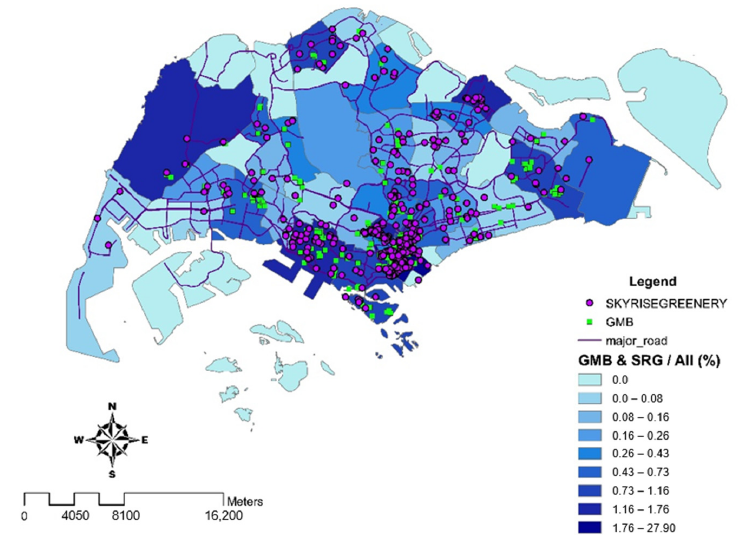
Figure 4. Spatial distribution of the percentage on a combination of both skyrise greenery (SRG) and Green Mark commercial buildings (GMB). Commercial districts such as Marina Barrage have an estimated 27.9% of GMB and SRG. This classification is based on Jenks’ Natural Breaks algorithm. Class breakdowns are determined for best group comparable data and maximize the differences across classes of SRG and GMB.